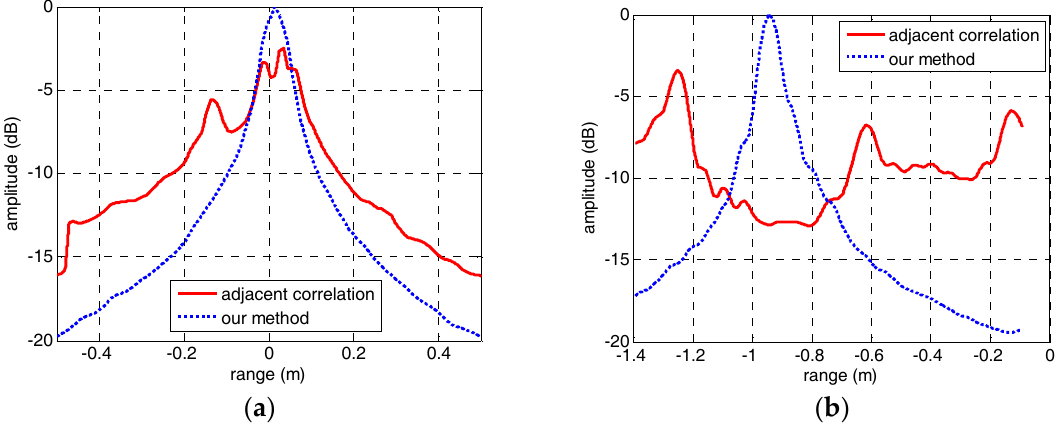
Figure 12. Comparison of the focusing performance of the IRT results through adjacent correlation correction and the method in this paper. ( a ) The adjacent correlation correction. ( b ) The method in this paper.